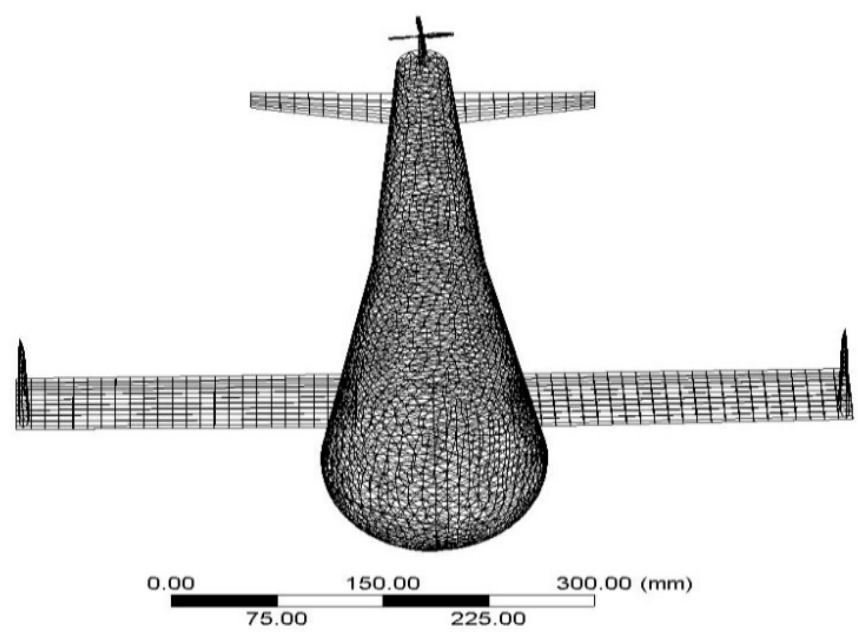
Figure 36. Discretised structure of optimised UAV.